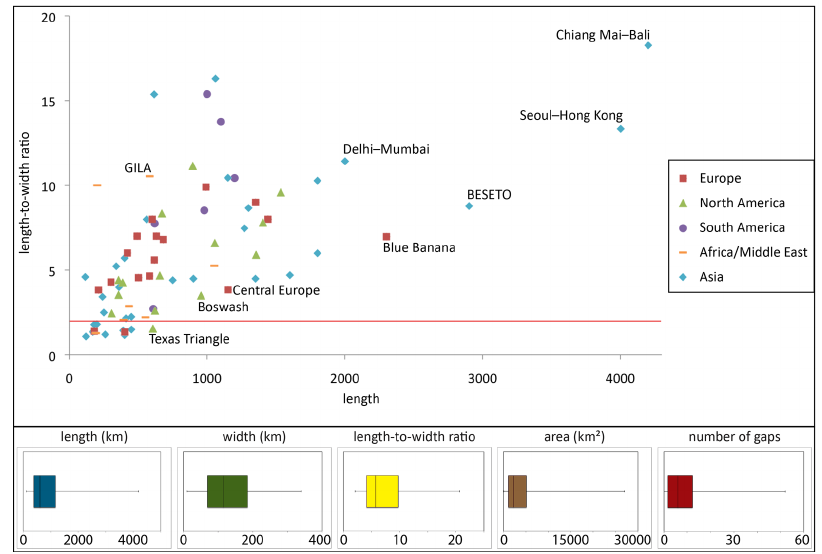
Figure 6. Top : Length (x-axis) and length-to-width ratio (y-axis) of urban corridors. All corridors with a ratio of less than two (red line) were removed from further analysis; Bottom : Range of properties of urban corridors.